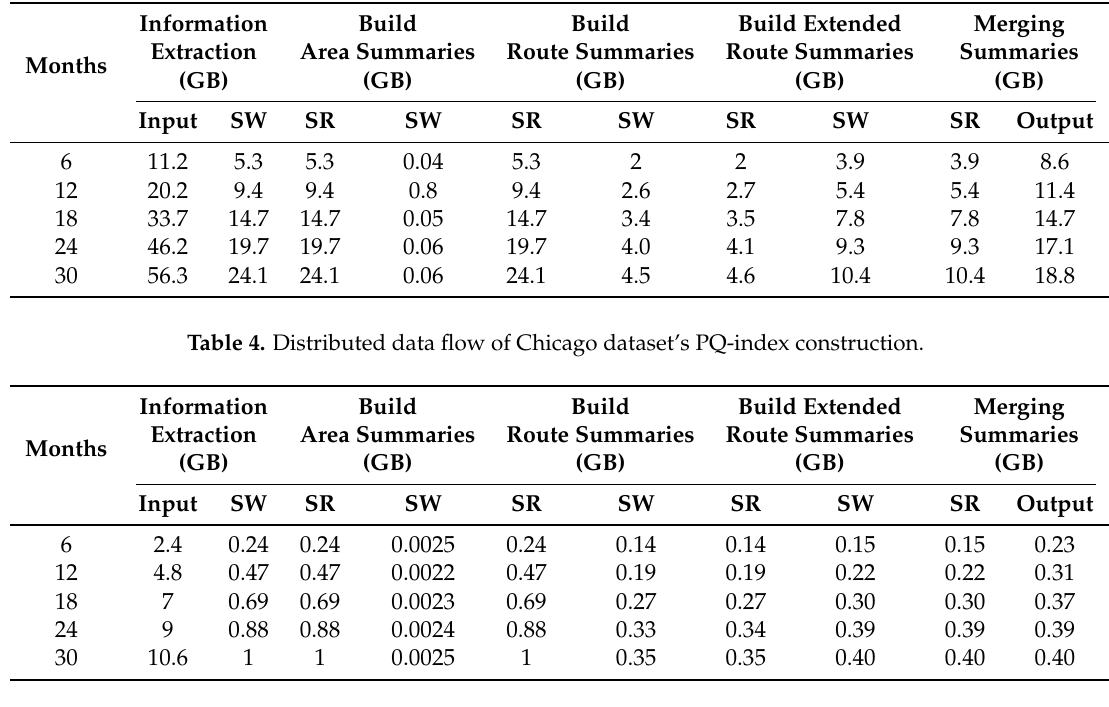
Table 3. Distributed data flow of NewYork dataset’s PQ-index construction.